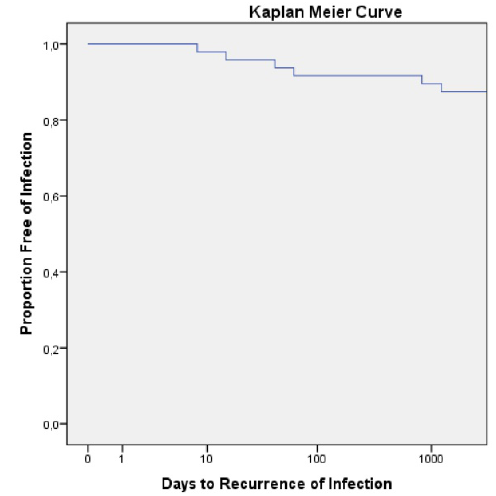
Figure 2. Kaplan-Meier survival curve that represents the proportion of all patients free of infection after treatment for deep SSI after instrumented spinal